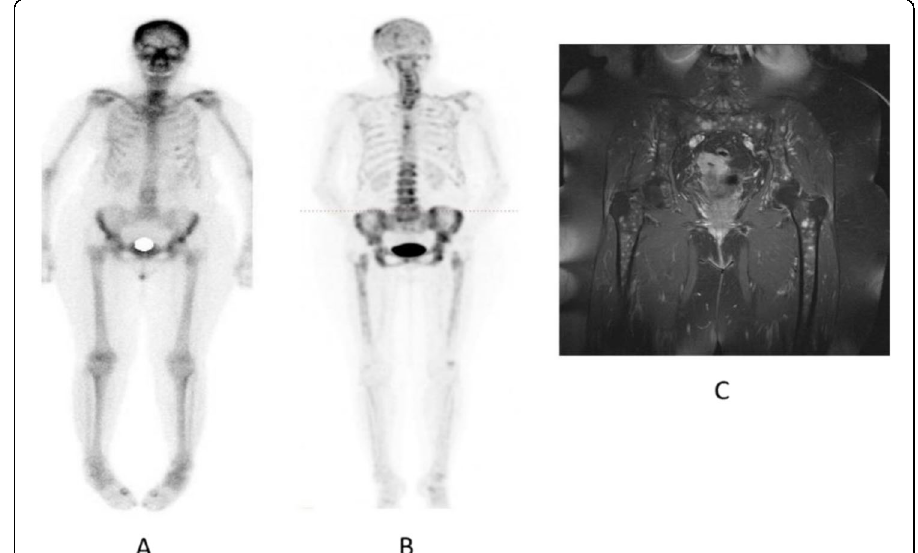
FAZA Names: 1-(5-[ 18 F] Fluoro-5-deoxy- α -D-arabinofuranosyl)-2-Nitroimidazole; 18 F-FAZA Biodistribution and metabolism (Fig. 66) F-18 FAZA is a 2-nitroimidazole compound (reduced in hypoxic cellular media) with a sugar addition moiety showing more water solubility and better pharmacokinetics compared to 18 F-FMISO (Zips et al. 2012; Bollineni et al. 2013; Bollineni et al. 2014). Scan acquisition